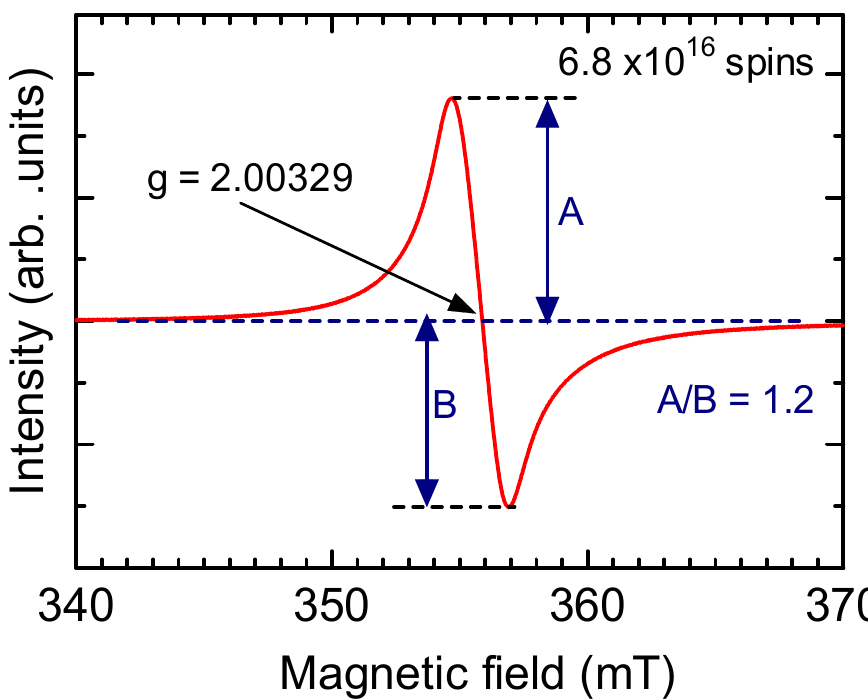
Figure 11. Electron spin resonance (ESR) result for m -CB(PANI).